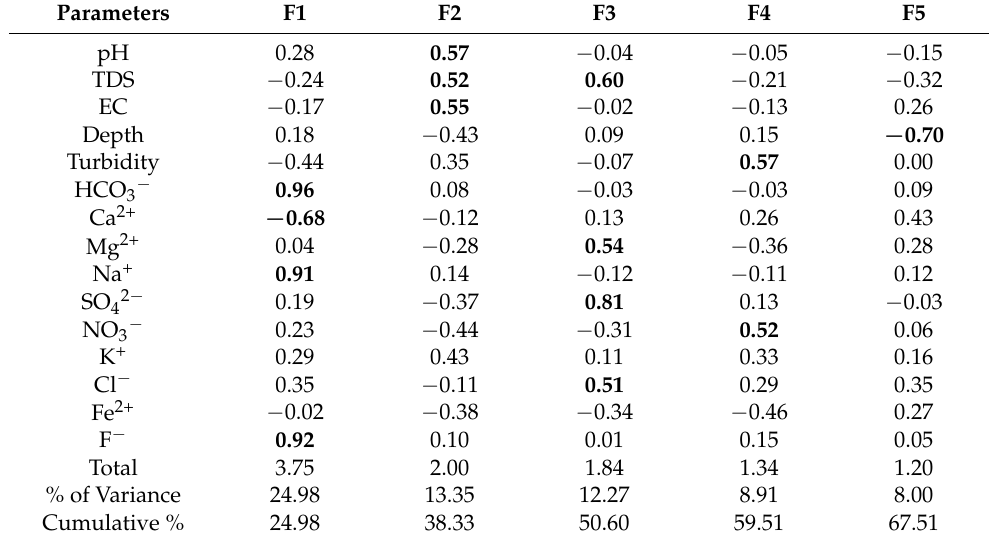
Table 2. Principal component analysis of selected parameters in the study area.